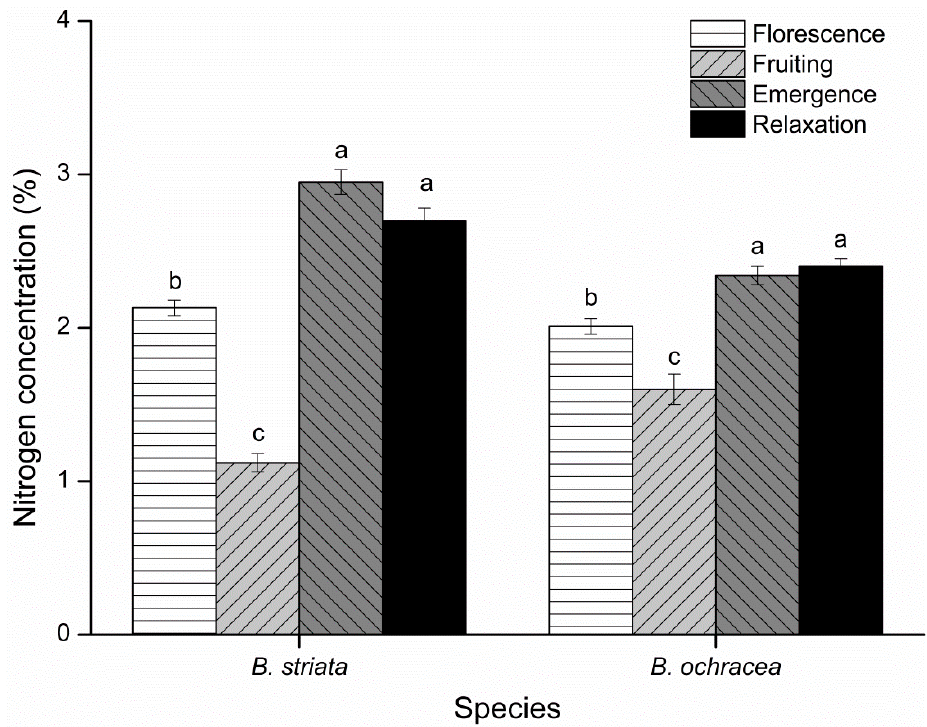
Figure 9. Temporal variation in leaf nitrogen concentration for Bletilla striata and B . ochracea . Different lowercase letters for each species indicate statistically significant differences among phenological stages ( p < 0.05).